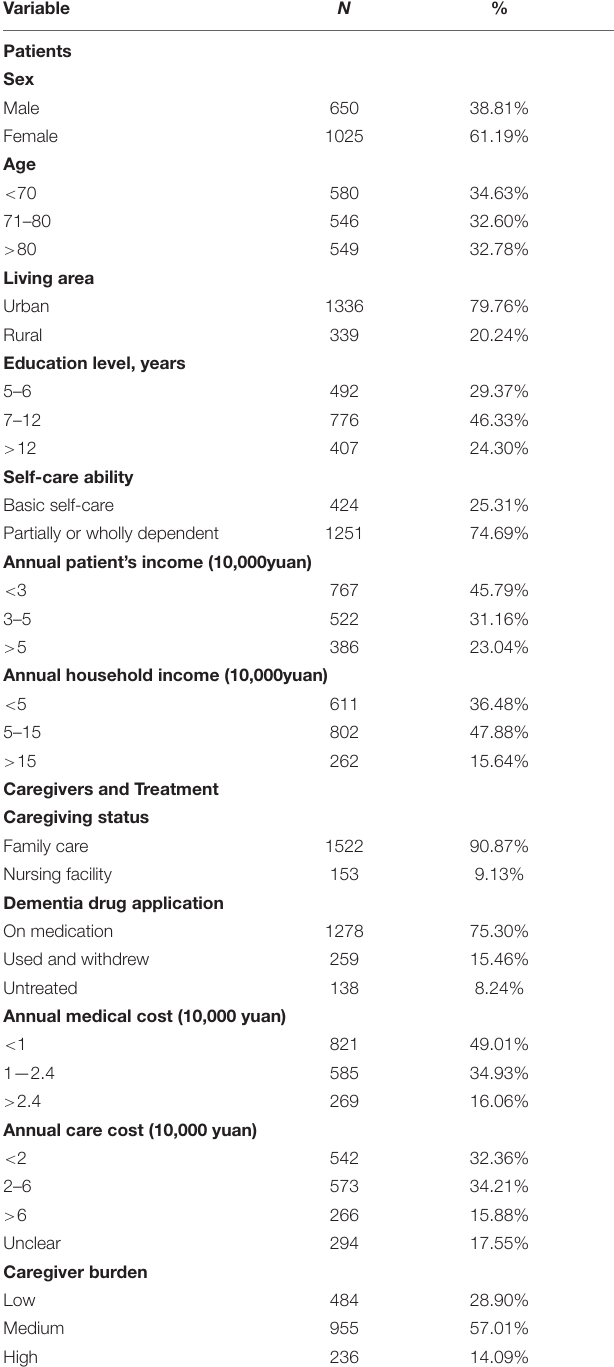
TABLE 1 | Characteristics of caregivers and patients with AD ( N = 1675).